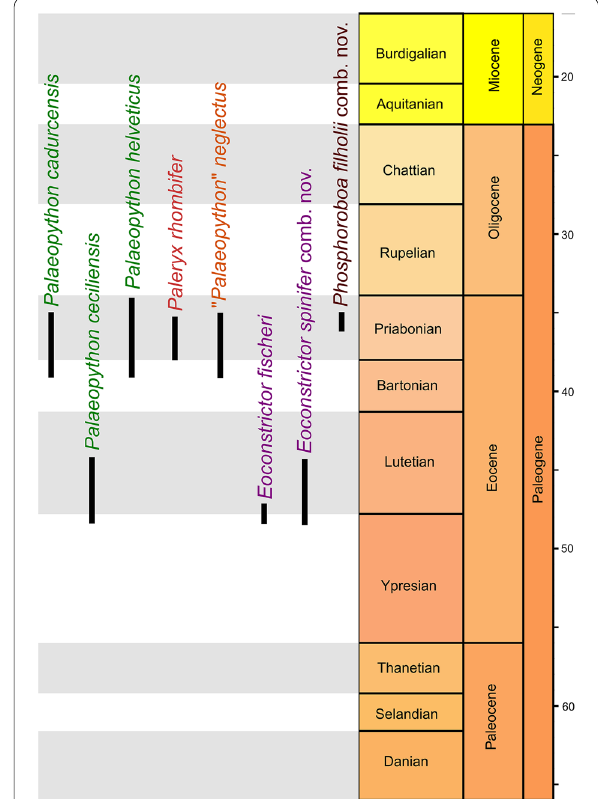
Fig. 113 Stratigraphic distribution of the valid species discussed in this paper. Note that the occurrences of Eoconstrictor cf. fischeri from Dielsdorf and Geiseltal are not included in the range of the species Eoconstrictor fischeri . Also, the range of the species Eoconstrictor spinifer comb. nov. appears larger than its actual one due to the uncertainty on the exact age of Geiseltal. Epochs and ages adapted from the International Chronostratigraphic Chart (www.stratigraphy. org; Cohen et al.,